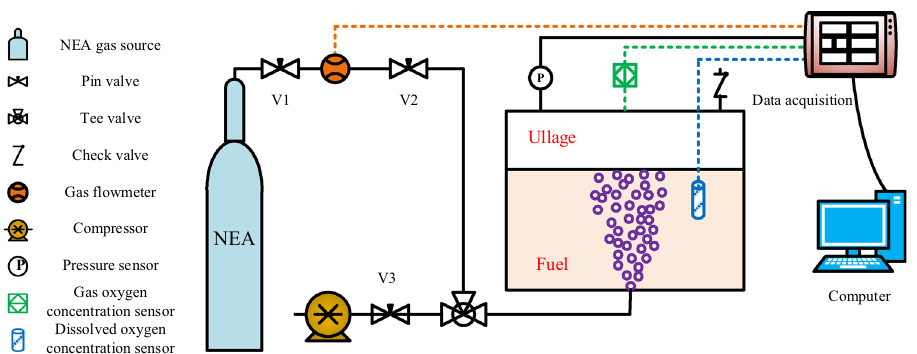
Figure 3. The experimental fuel scrubbing system